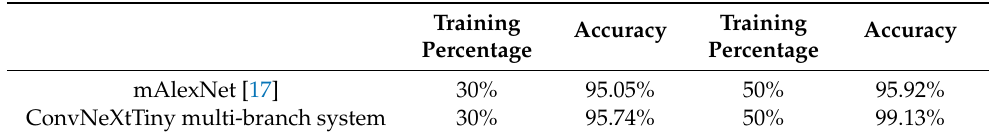
Table 10. Comparison between the ConvNeXtTiny multi-branch system and the mAlexNet sys- tem [17] for the ETSIT dataset with reduced training sets.